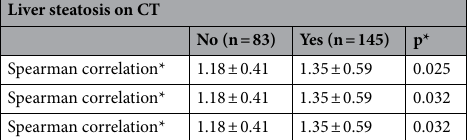
Percentile degree of hepatic steatosis (%) Pancreas mean steatosis